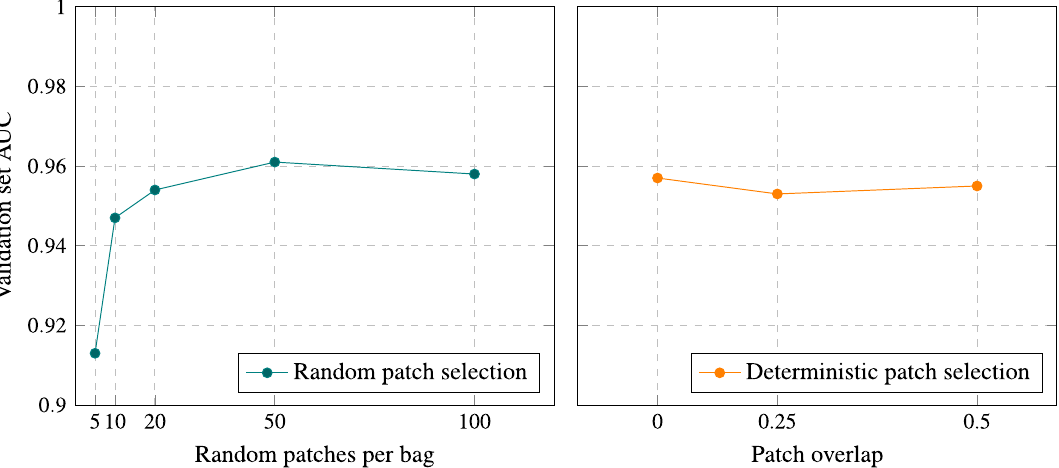
Figure 6. AUC scores on the Kaggle validation set for the random patch selection policy (left) and the deterministic patch selection policy (right). In the case of random patch selection, we examine the effect of K (number of randomly selected patches per image) on validation performance, while for the deterministic patch selection we examine the effect of t (patch overlap